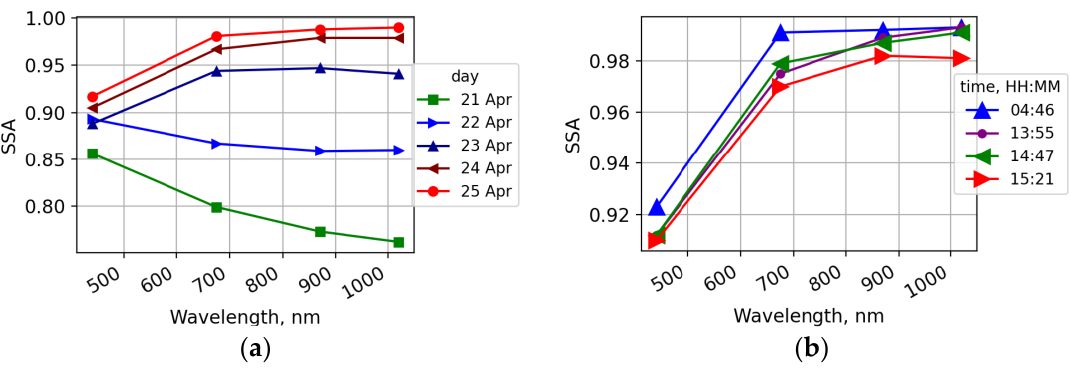
Figure 4. The single-scattering albedo (SSA) ( a ) 21 – 25 April and during the day of ( b ) 25 April 2019. Data level 1.5 for ( a ) 21 – 25 April and level 2.0 for ( b ) 25 April.